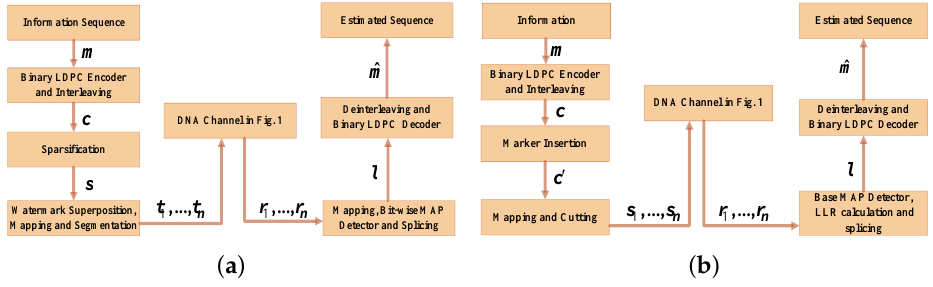
Figure 2. The procedure of the concatenated watermark code scheme and the concatenated marker code scheme. ( a ) Concatenated watermark code scheme; ( b ) Concatenated marker code